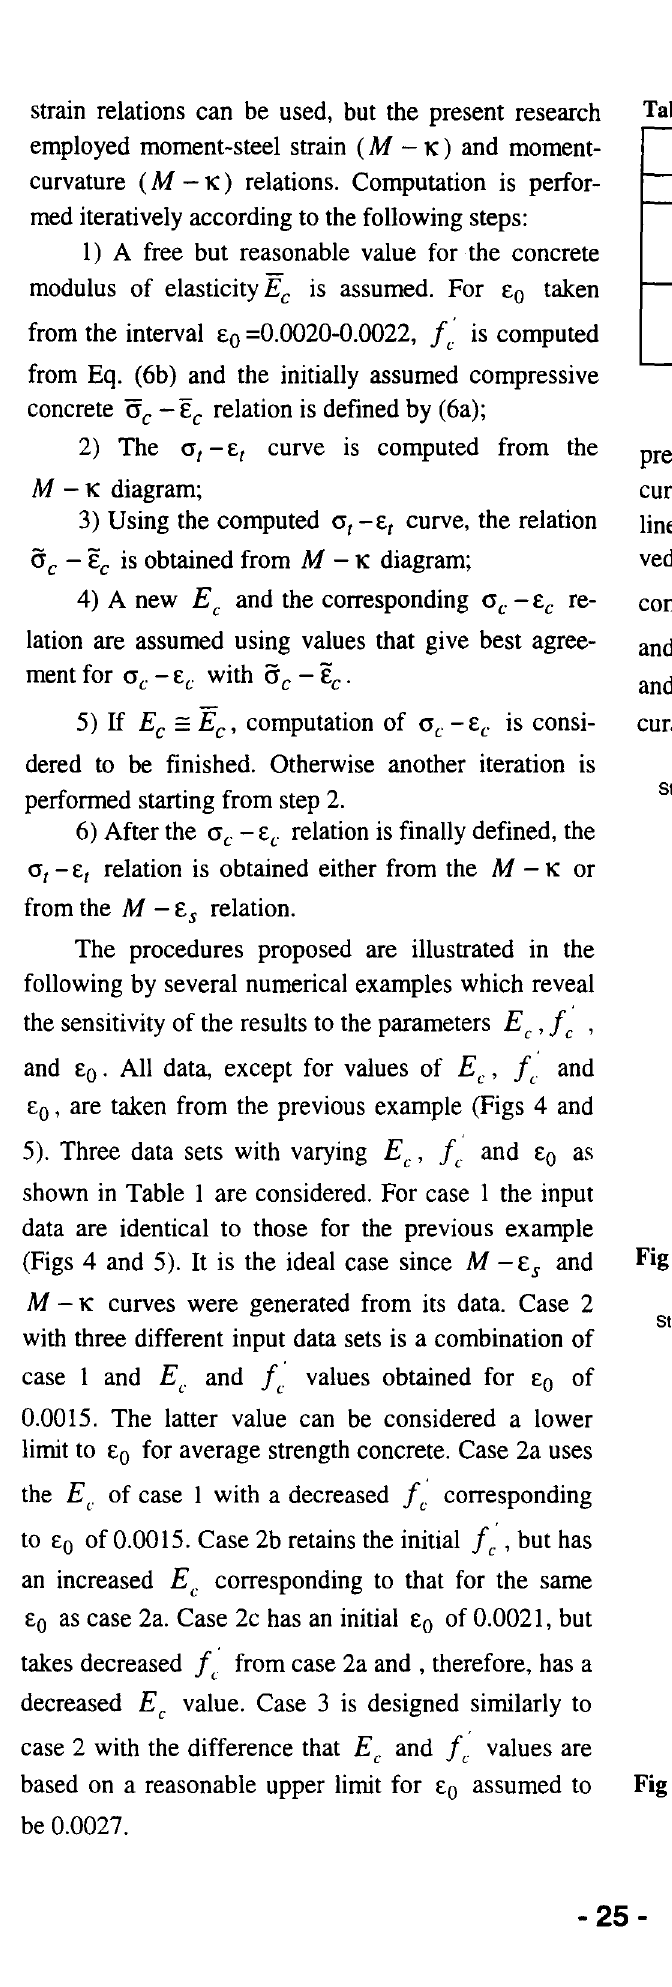
Fig 8. Computed crt -Et curves for case